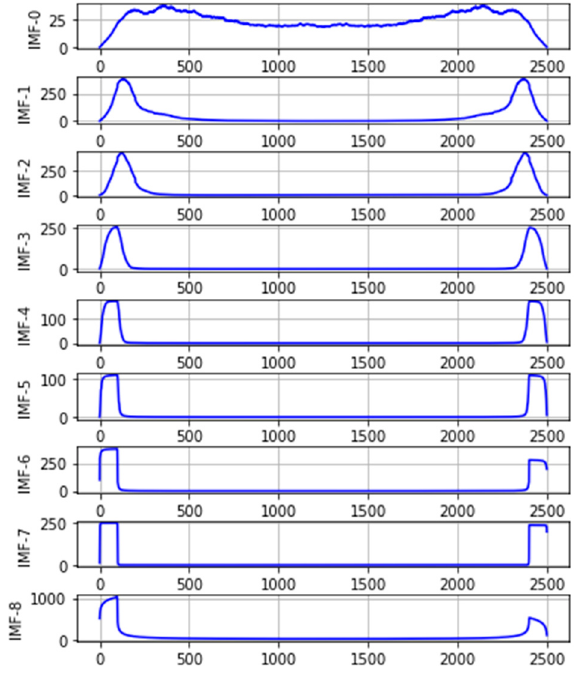
Figure 4. Convolution results for each IMF in the frequency domain.